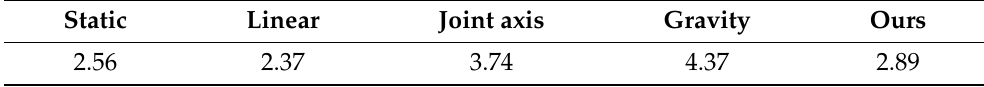
Table 2. Dispersion of the calibration